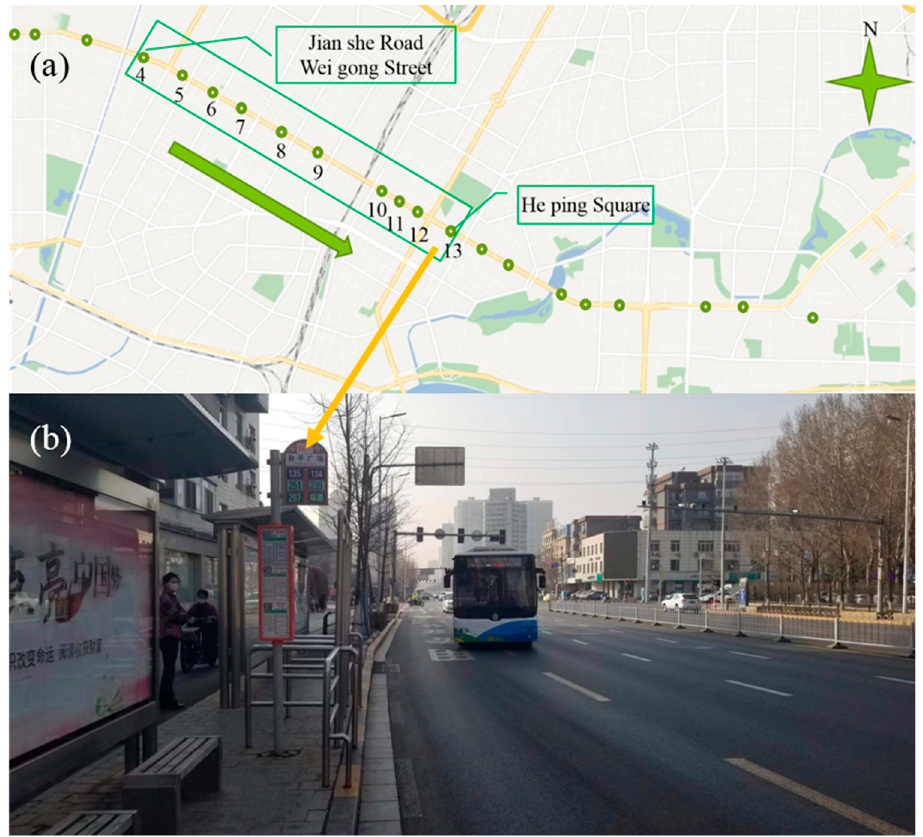
Figure 4. ( a ) Route map of bus No. 239, ( b ) photo of 239 Bus Route.